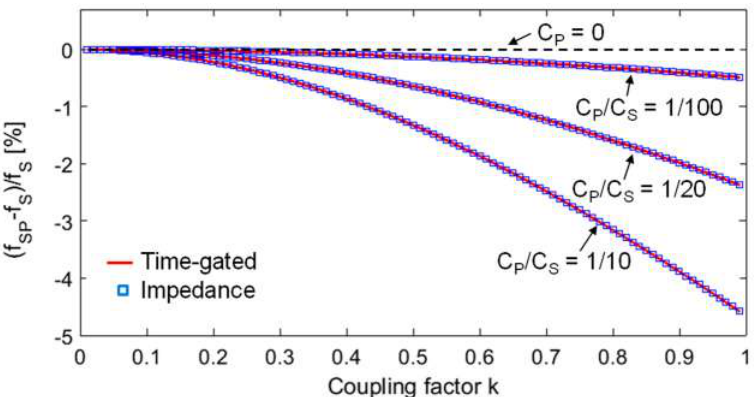
Figure 11. Comparison of the ( f SP − f S )/ f S obtained from the two techniques as a function of k for three different values of the ratio C P /C S . The exact value of f S without the parasitic capacitance, i.e., C P = 0, is f S = 5.626977 MHz.